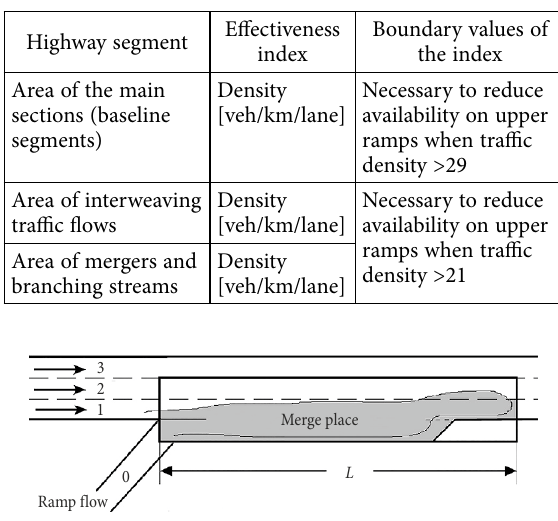
Fig. 2. The study on congestion formation in the merge